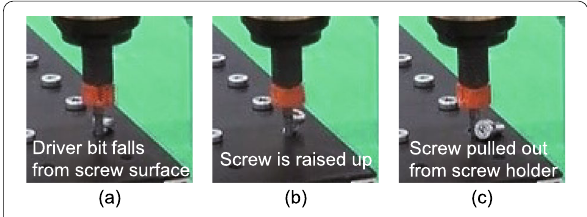
Fig. 12 Task execution result: task aborted due to failed screw